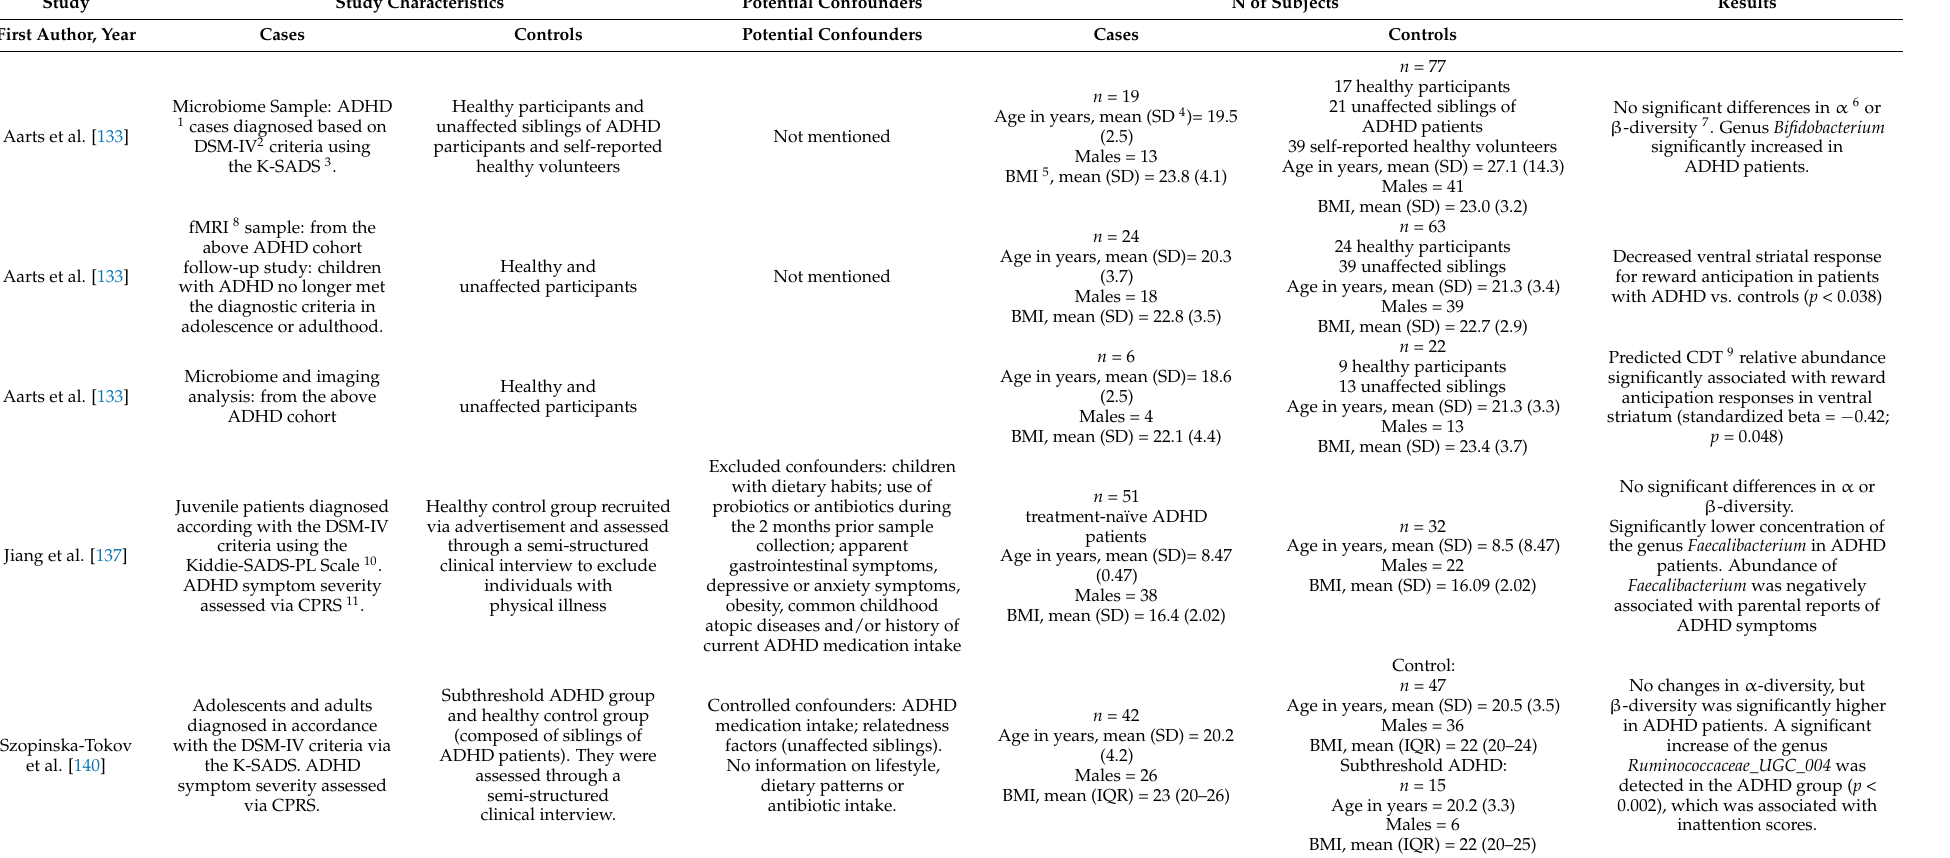
Table 1. Characteristics of included studies analyzing differential microbial composition in patients with attention deficit/hyperactivity disorder